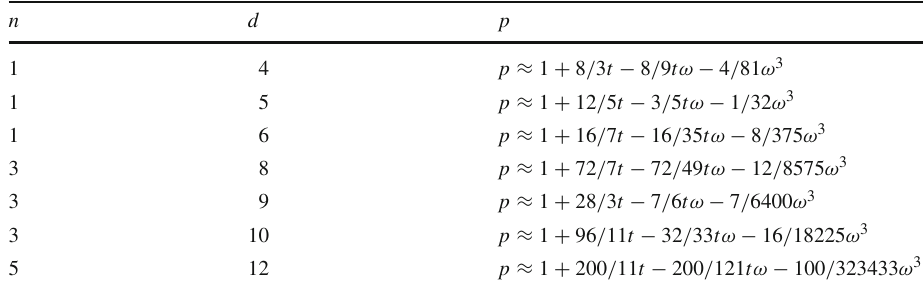
Table 2 Behavior of pressure near critical